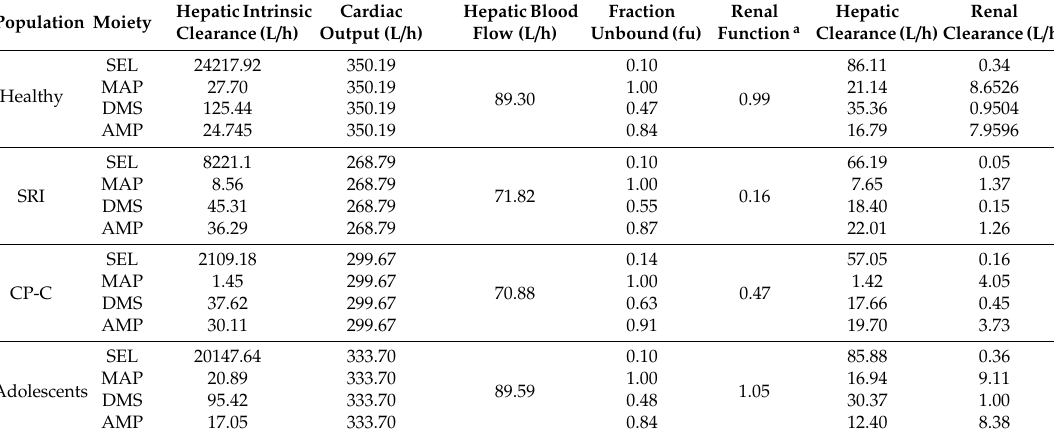
Table 3. Hepatic and renal clearance of selegiline and its metabolites in di ff erent populations. HepaticIntrinsic Cardiac HepaticBlood Fraction Renal Hepatic Renal Population Moiety Clearance(L / h) Output (L / h) Flow (L / h) Unbound(fu) Function a Clearance(L / h) Clearance(L /